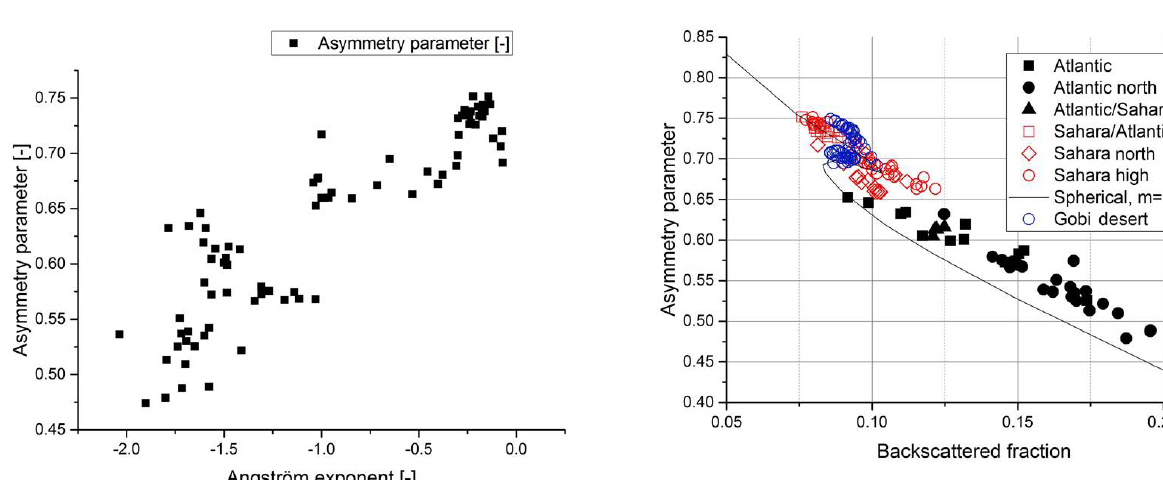
Figure 10. Asymmetry parameter and backscattered fraction calcu- lated for the aerosols measured during this study. A clear separation between Sahara and non-Sahara aerosols is evident. The data points are in excellent agreement with data for the Gobi desert